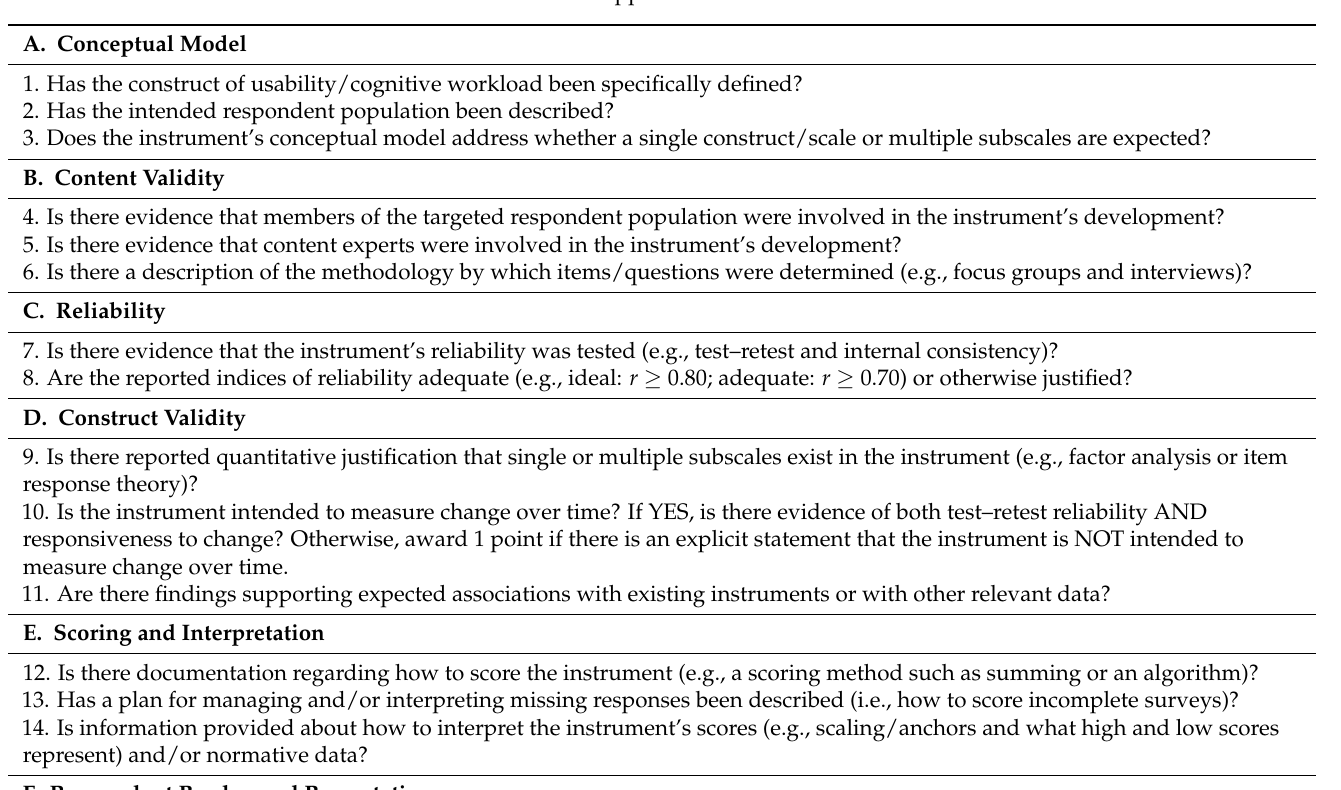
Table 1. Checklist for the critical appraisal of retrieved assessment methods 1